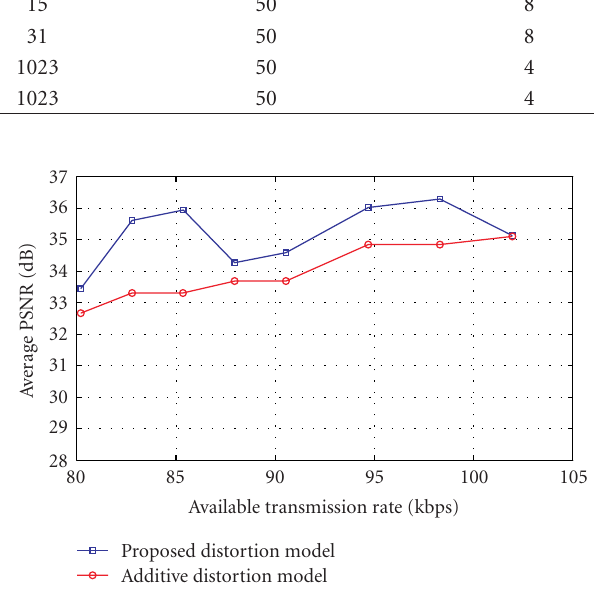
Figure 1: Average PSNR (in dB) as a function of available transmis- sion rate (in kbps) for the “even-loss distribution” algorithm. Com- parison between the proposed and the simplified “additive” distor- tion model for the video sequence Foreman